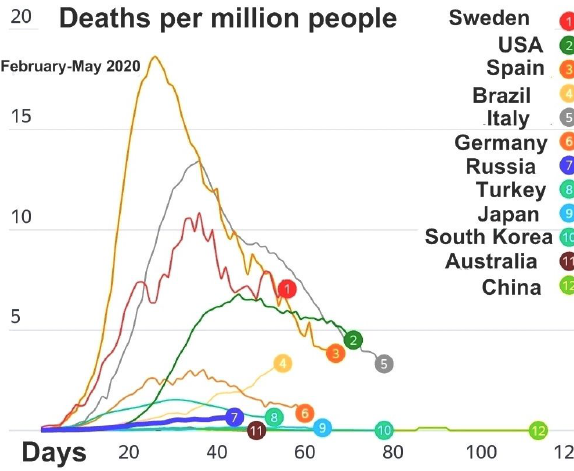
Figure 1. Deaths of coronavirus pandemic per 1 million